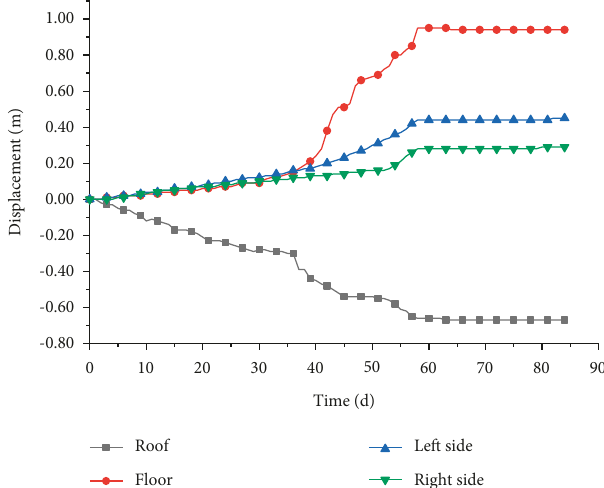
Figure 23: Displacement monitoring curve of no. 1 section of prototype roadway.